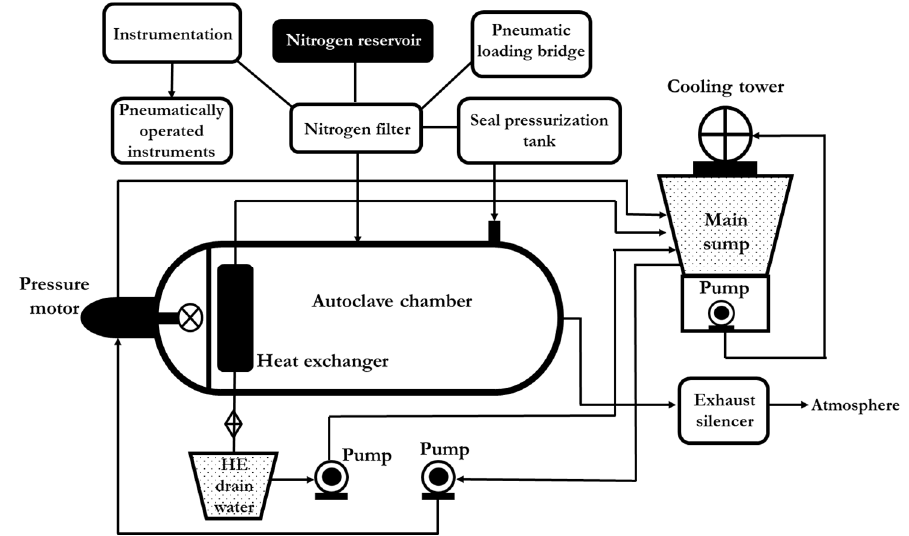
Figure 5. Schematic of cooling and pressurization system in an autoclave (redrawn from [17]).